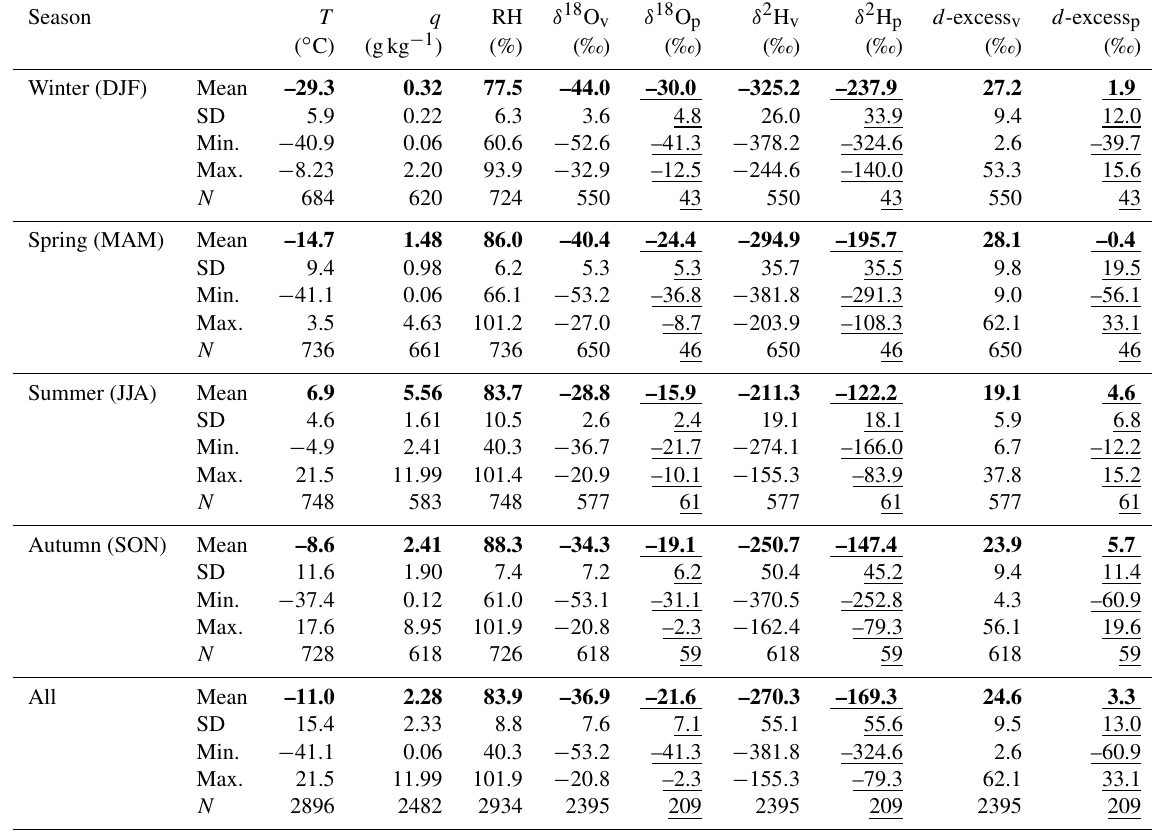
Table 1. Averaged values (bold characters), standard deviations, minima, maxima and the number of values for all seasons and for the whole dataset within the period 1 July 2015 to 30 June 2017, with a 6h averaged dataset for air temperature ( ◦ C), specific humidity q (kg − 1 ), relative humidity (%), δ 18 O v (‰), δ 18 O P (‰), δ 2 H v (‰), δ 2 H p (‰) d -excess v (‰) and d -excess p (‰). Underlined values correspond to precipitation sample